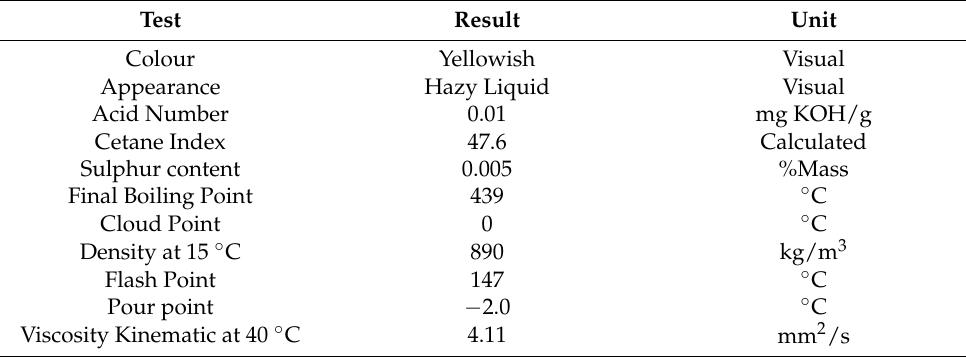
Table 12. Biodiesel produced